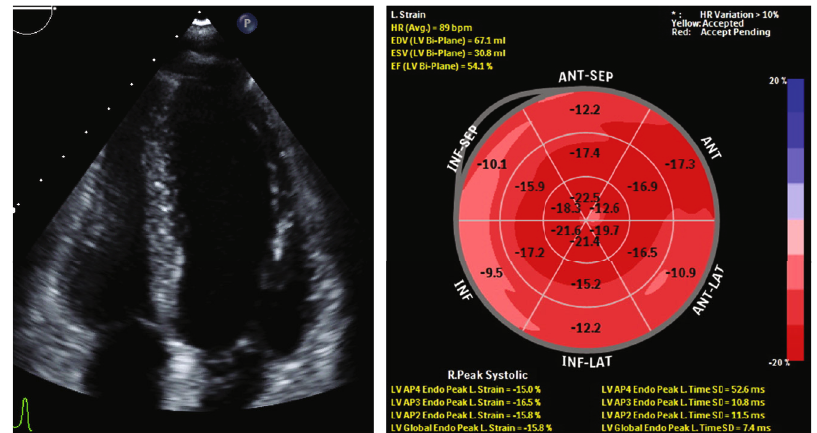
Figure 3: Echocardiographic examination at 6 months after patient ’ s discharge from